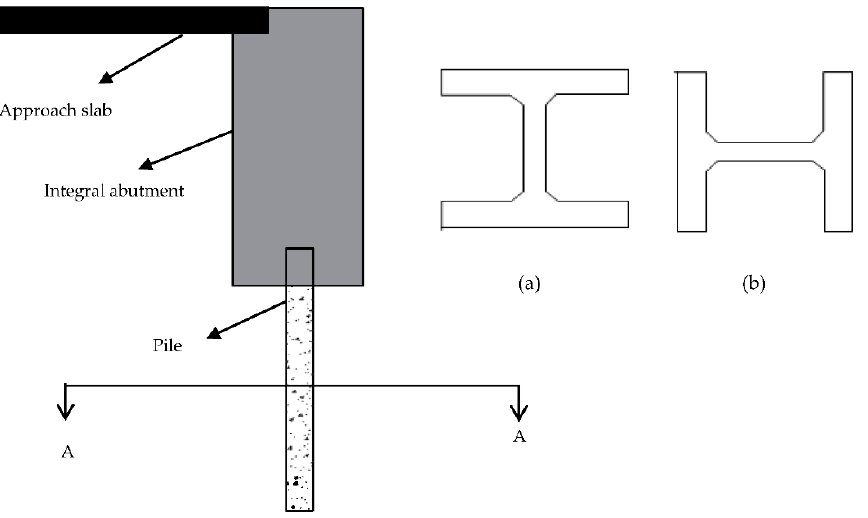
Figure 5. Orientation of the H-pile: ( a ) pile bent along the weak axis; ( b ) pile bent along the strong axis.